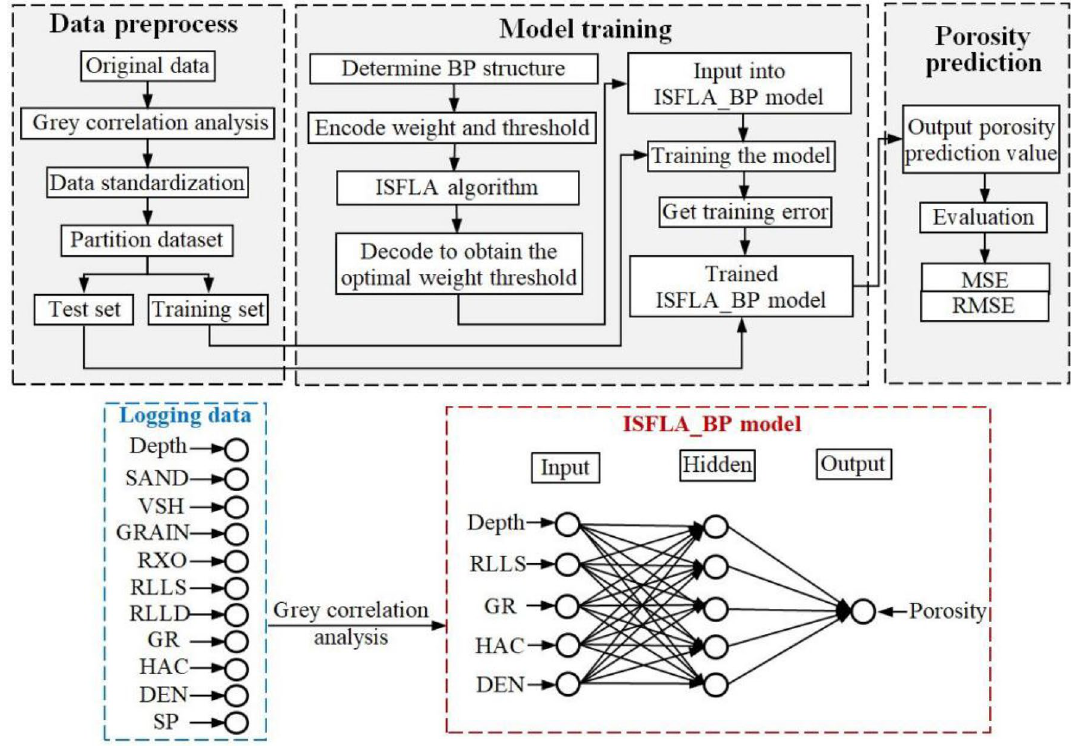
Fig. 7 Porosity prediction process based on the ISFLA_BP model